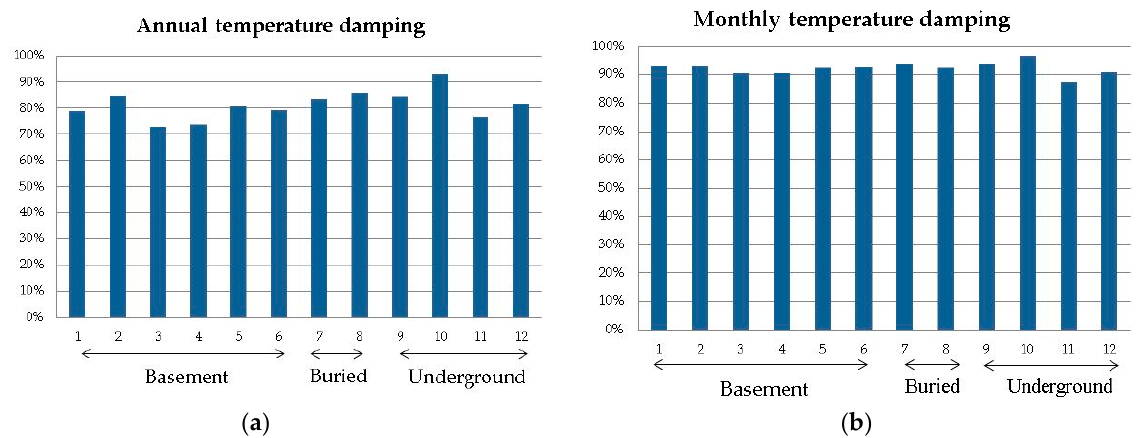
Figure 6. Damping of temperature in buildings analyzed ( a ) Annual temperature damping; ( b ) Monthly temperature damping.